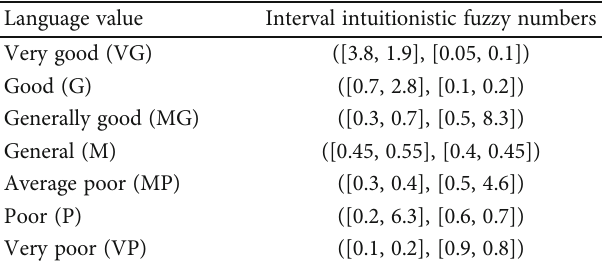
Table 2: Intuitive fuzzy number conversion between zones.